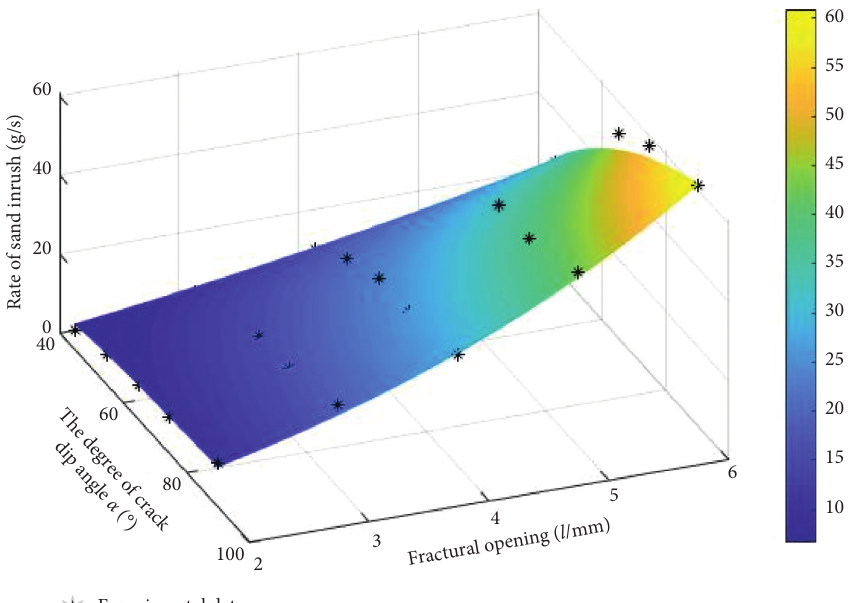
Figure 12: Sand inrush velocity distribution diagram considering both opening degree and inclination of